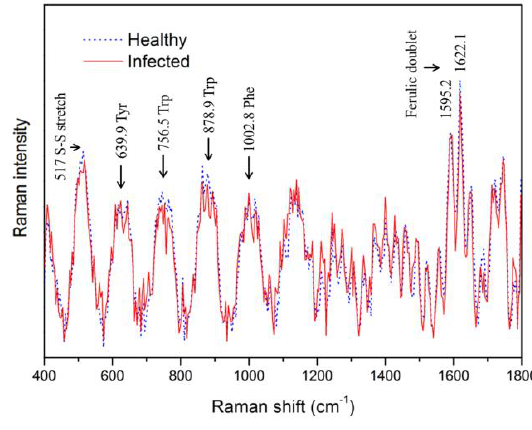
Figure 5. Mean corrected Raman spectra of bacteria-infected and healthy watermelon seeds obtained by removing the fluorescence signal using a polynomial equation.